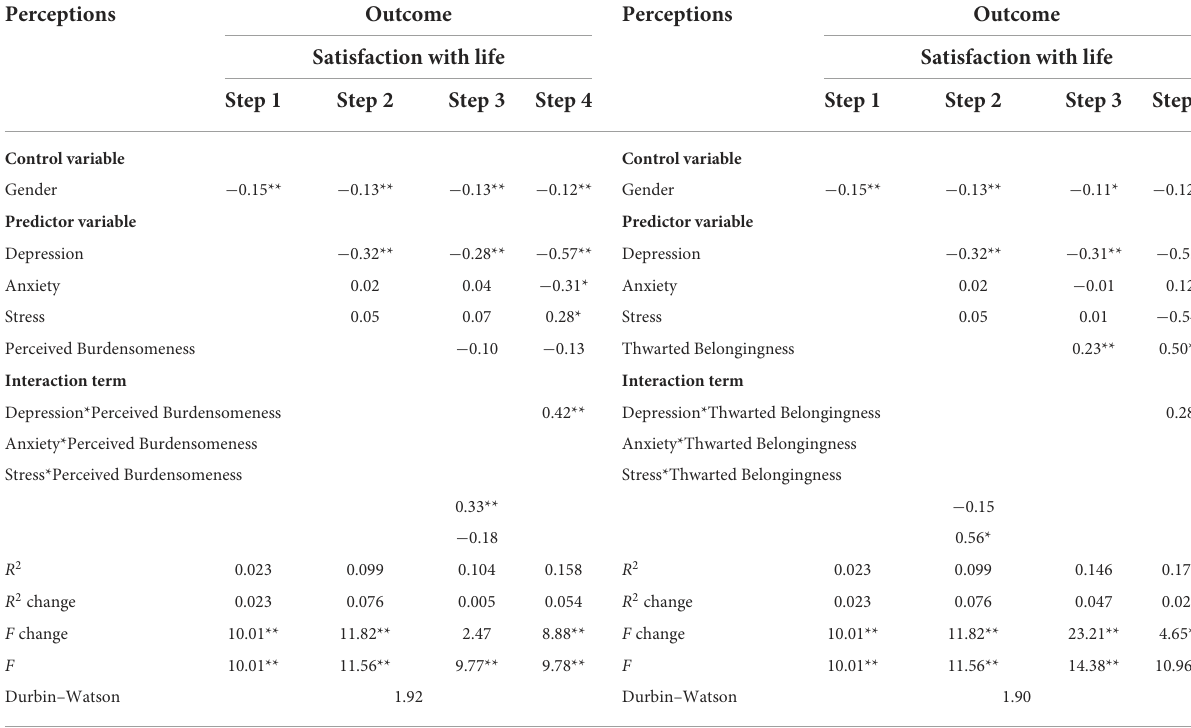
TABLE 5 Hierarchical regression analysis: moderating effects of perceived burdensomeness and thwarted belongingness.